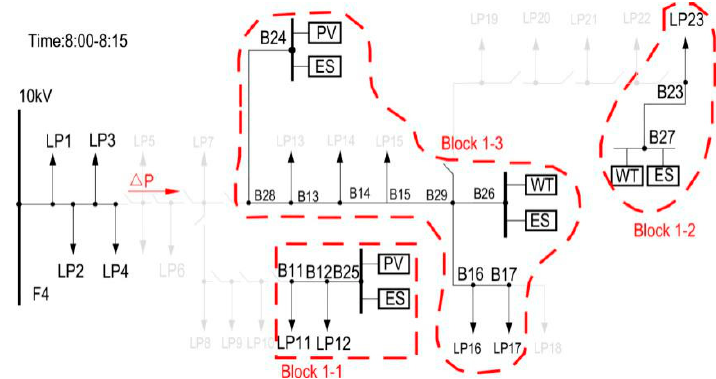
Figure 5. 8:00–8:15 division of decision-making body.